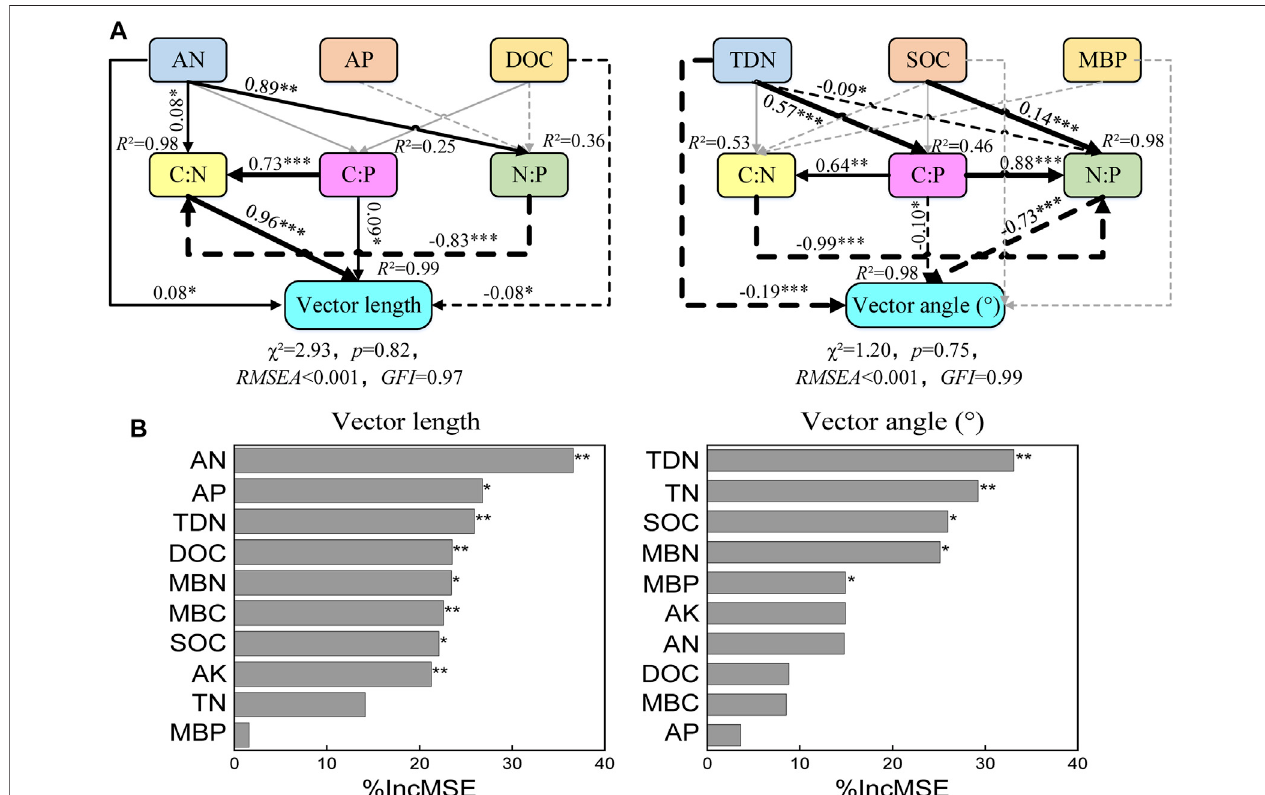
FIGURE6| Relationshipsofmicrobialresourcelimitationwithsoilproperties. (A) Structuralequationmodelingwasusedtoidentifythepossiblepathwaysbywhich attributes controlled microbial C limitation (represented by vector length) and microbial P limitation (represented by vector angle). Solid and dashed arrows indicate positiveandnegativerelationships( p < 0.05),respectively.Thenumbersonthearrowsindicatesigni fi cantstandardizedpathcoef fi cients. R 2 indicatesthevarianceofthe dependent variable explained bythemodel. (B) Importance analysisoffactors affectingmicrobialmetabolic limitation insoil (random forest analysis). **, p < 0.01;*, p < 0.05. See Materials and methods for abbreviation de fi nitions.